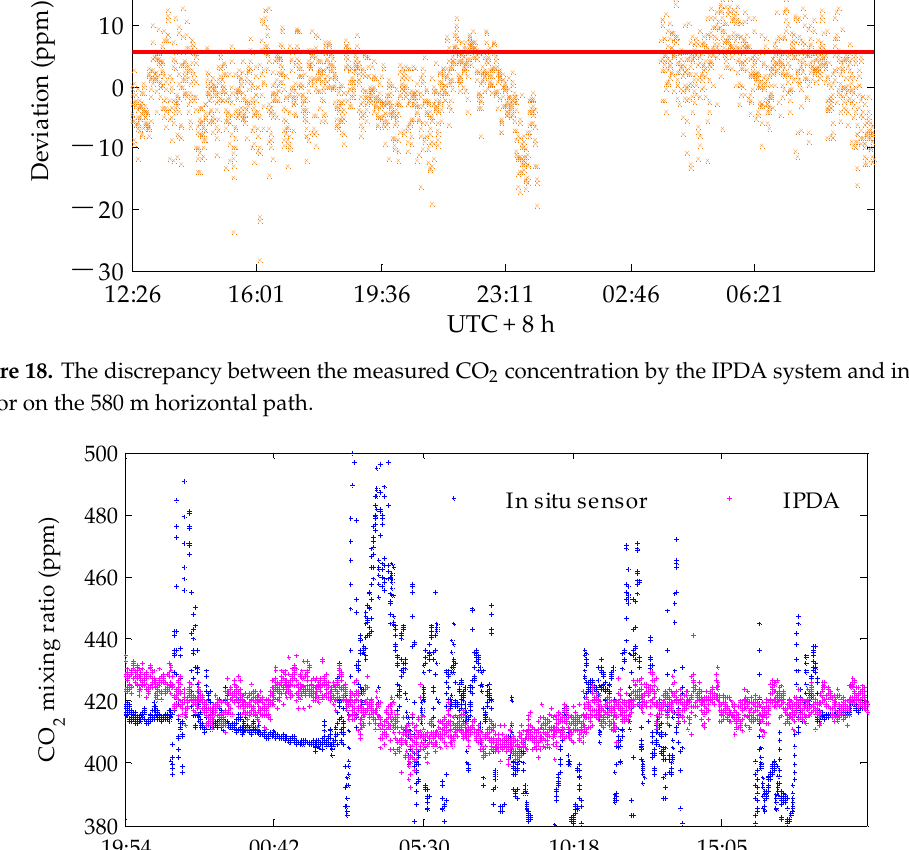
Figure 19. Simultaneous measurements of the diurnal variations of atmospheric CO 2 with the improved